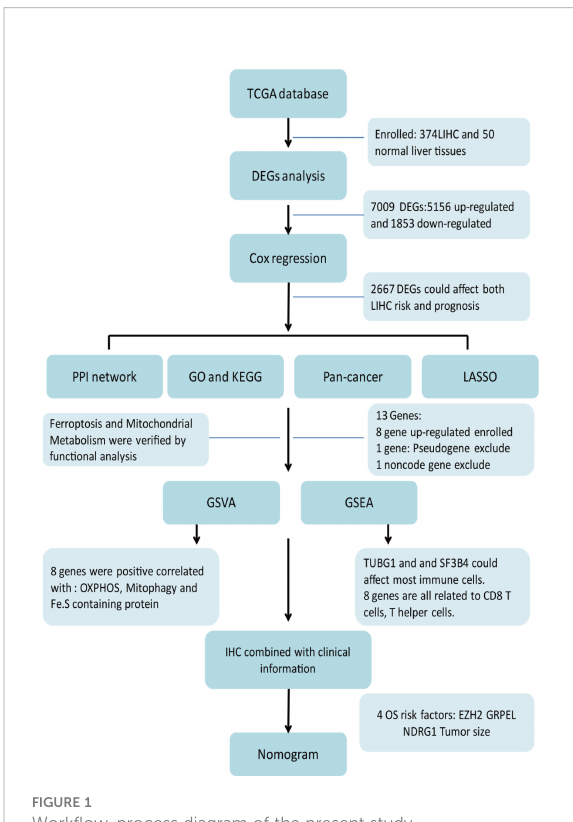
FIGURE 1 Work fl ow-process diagram of the present